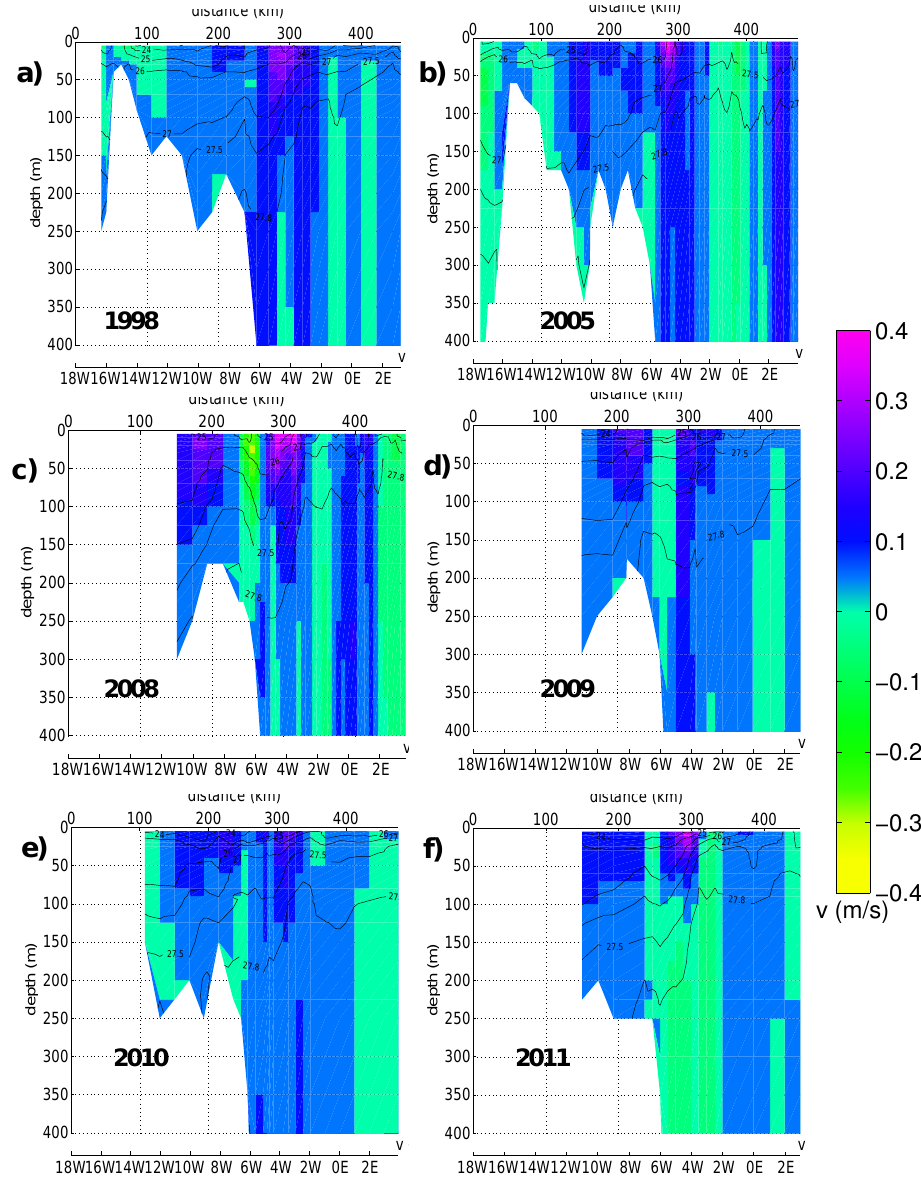
Fig. 3. Baroclinic component of the meridional velocity shown in Fig. 2: (a) 1998, (b) 2005, (c) 2008, (d) 2009, (e) 2010 and (f) 2011.